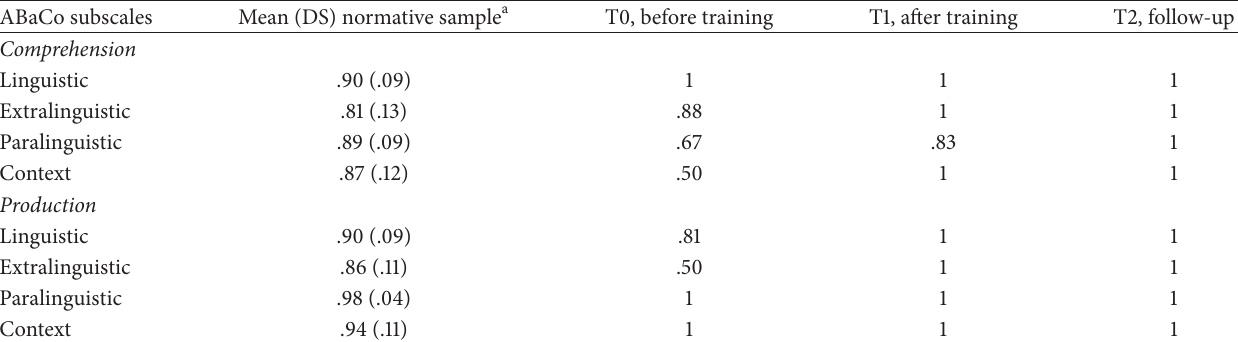
Table 2: Scores obtained by S.T. at the subscales of ABaCo at T0, before training, T1, after training, T2, follow-up, and normative